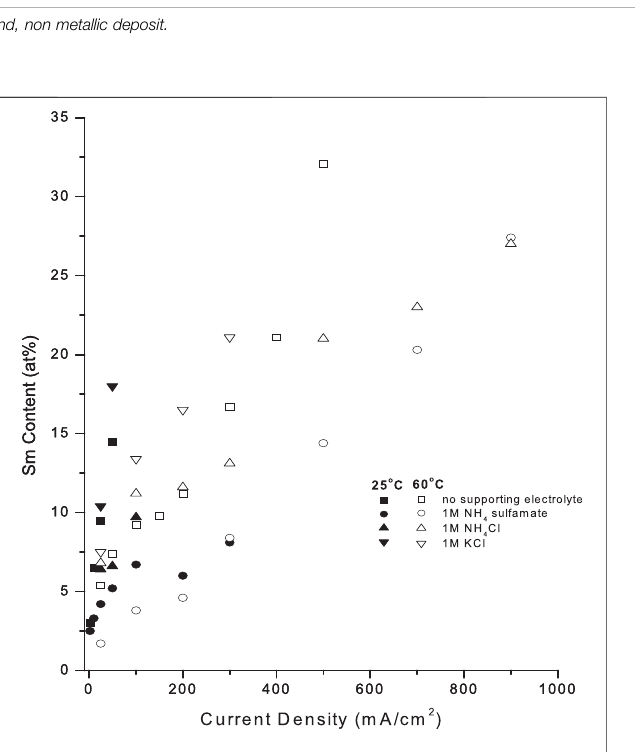
FIGURE 10 | Effect of supporting electrolyte on samarium deposit content at (A) 25 ° C (closed pts) and (B) 60 ° C (open pts) [Note- draw continuous and dashed connecting